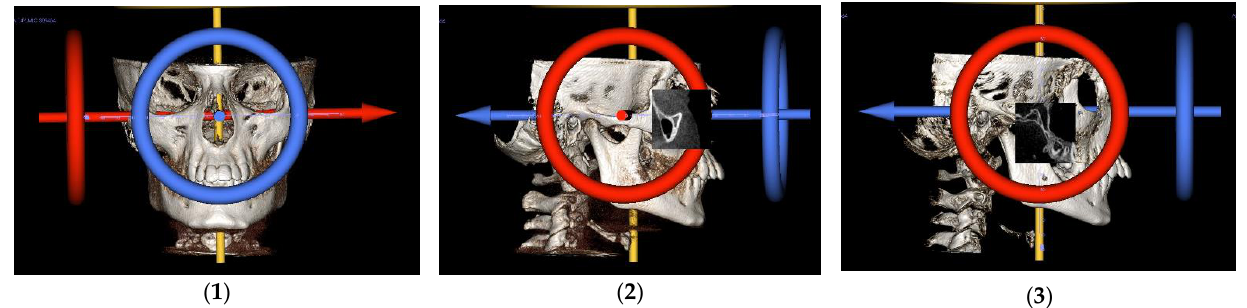
Figure 2. Bilaterally oriented 3D reconstructed CBCT image: ( 1 ) frontal view showing grid passing through right and left orbitale in transverse plane; ( 2 ) lateral view showing grid passing through right porion and right orbitale in transverse plan; and ( 3 ) lateral view showing grid passing through right and left Pterygomaxillary fissures in coronal plane. After orientation of the skull, standardization was carried out on MPR view to measure condyle-glenoid fossa variables. The Y-axis was set tangent through pterygoid vertical; the z-axis was placed along centre of sigmoid notch on axial section; and the x-axis (on sagittal section) was scrolled to be placed tangent to sigmoid notch (Figure 3). The procedure was followed for both right and left condyles and for all patients.